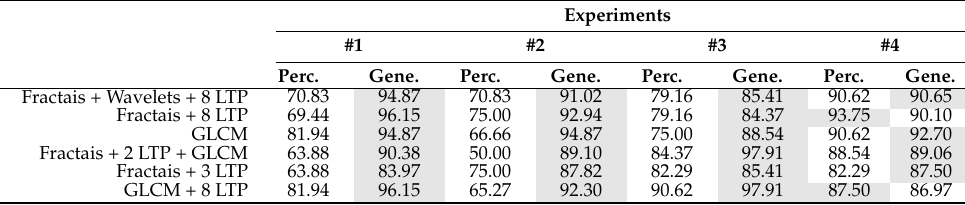
Table 13. Comparing Genetic and Percentile techniques for feature selection.